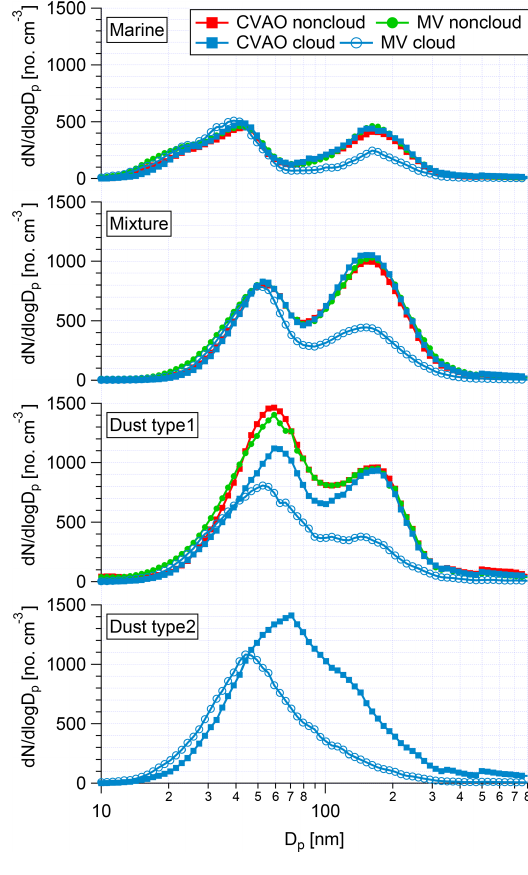
Figure 8. The median of PNSDs for four different particle types during cloud events and noncloud events at CVAO and